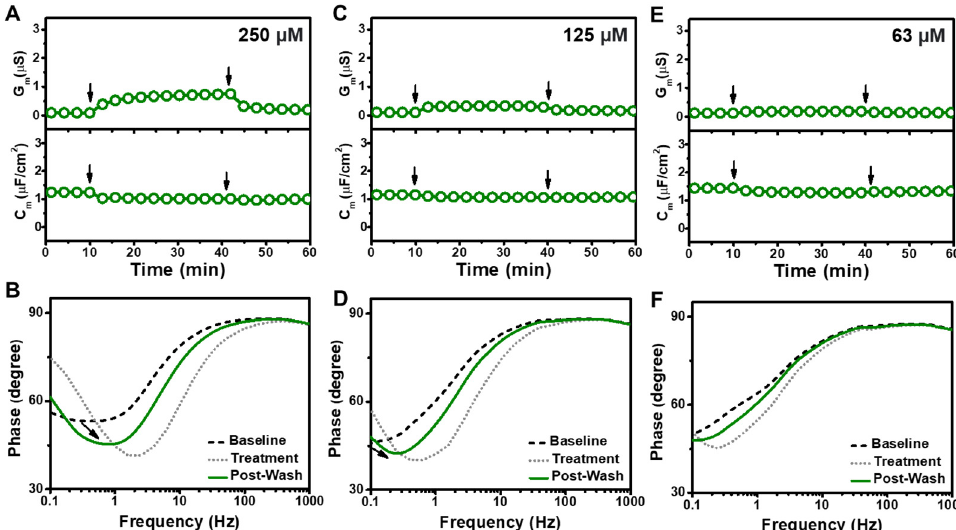
Figure 5. ( A ) Time-resolved conductance (G m ) and capacitance (C m ) shifts upon 250 µM SDS addition to the tBLM platform. The arrows indicate compound addition at t = 10 min and buffer washing at t = 40 min, respectively. ( B ) Bode plots for 250 µM SDS addition to the tBLM platform, whereby baseline, treatment, and post-washing reflect the initial measurement signal, signal after compound addition, and signal after buffer washing, respectively. Corresponding data for ( C , D ) 125 µM SDS and ( E , F ) 63 µM SDS addition to the tBLM platform.